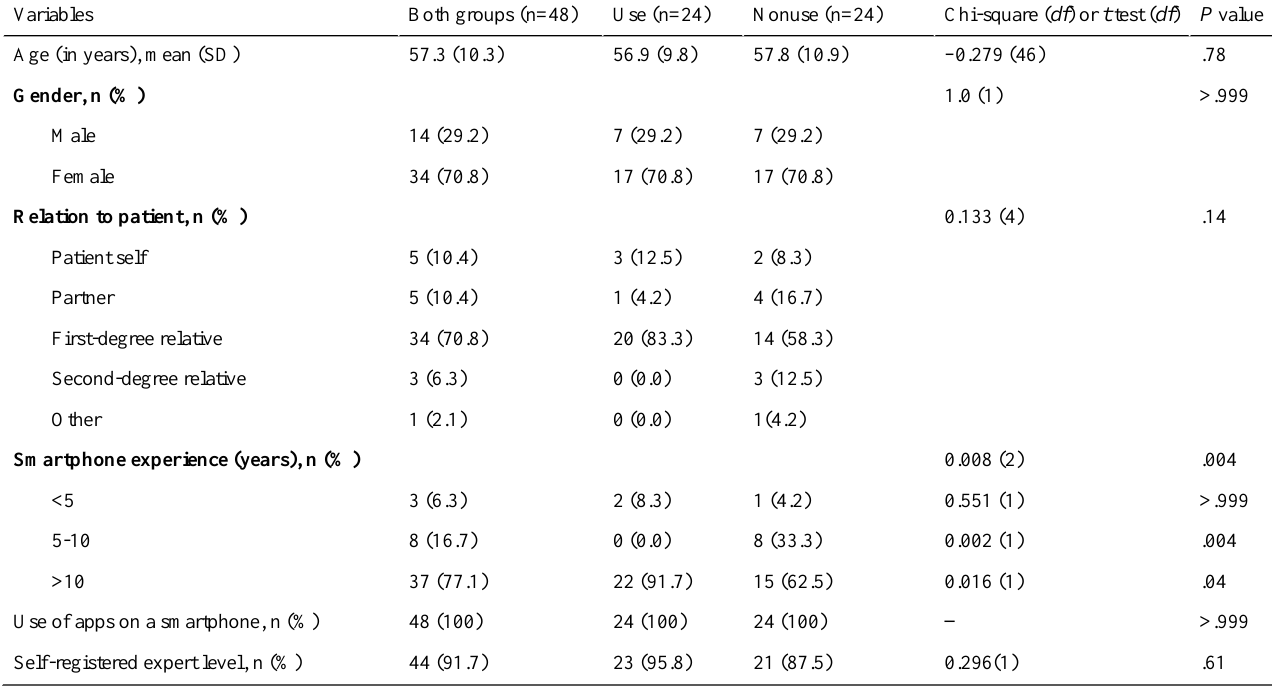
Table 2. Comparison of baseline characteristics between the use (participants downloaded the app) and nonuse (participants did not download the app)